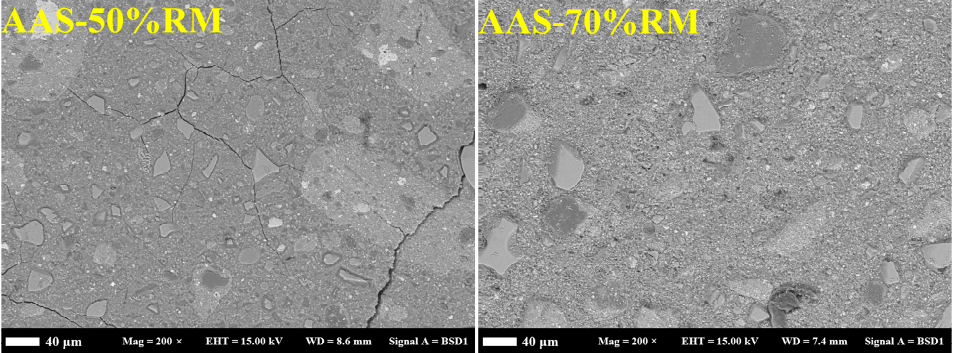
Figure 10. BSE images of alkali slag-red with different additions of RM.